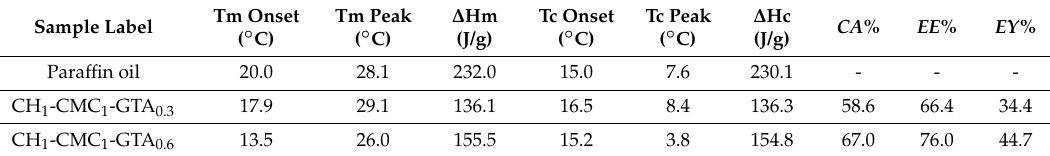
Table 1. Thermal properties of CH–NaCMC-based